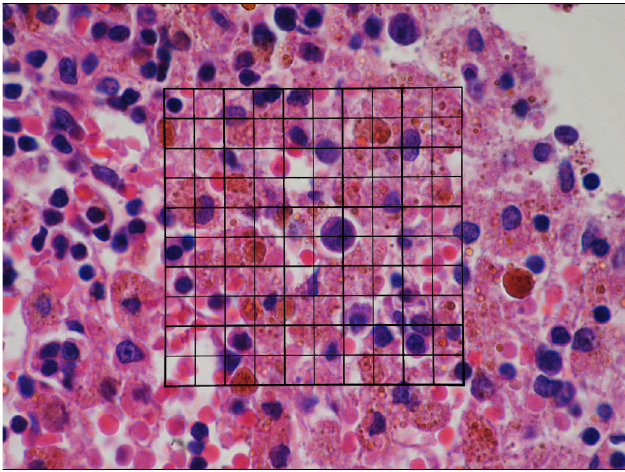
FIGURE 1 - Digital picture of histological cut (H.E. - 100x), put upon with a reticulum with 100 quadrants of 1mm² each, used for counting of the cells of the splenic